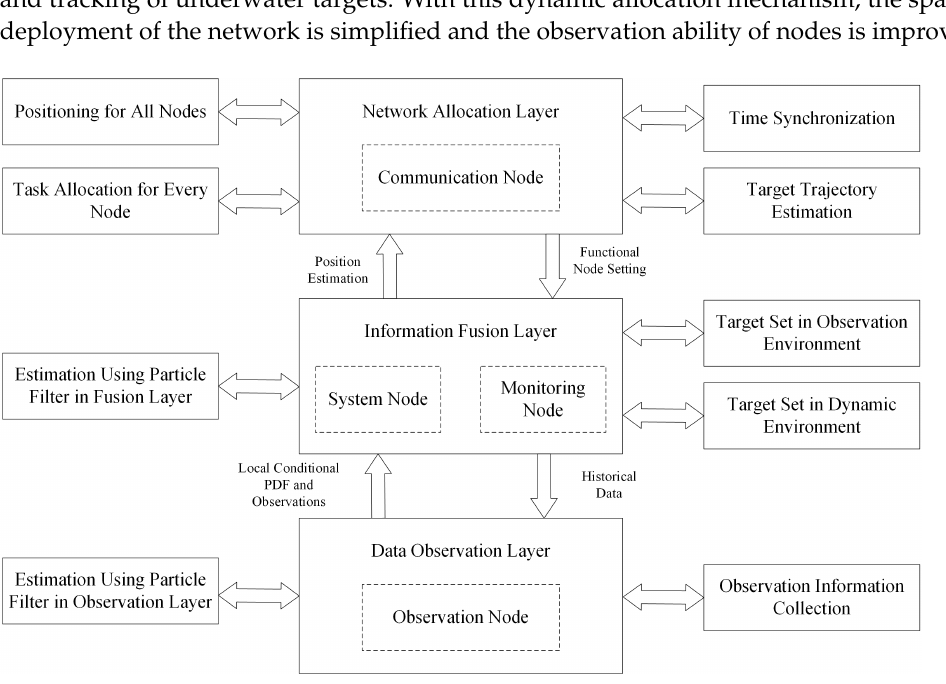
Figure 1. Diagram of network resource dynamic allocation